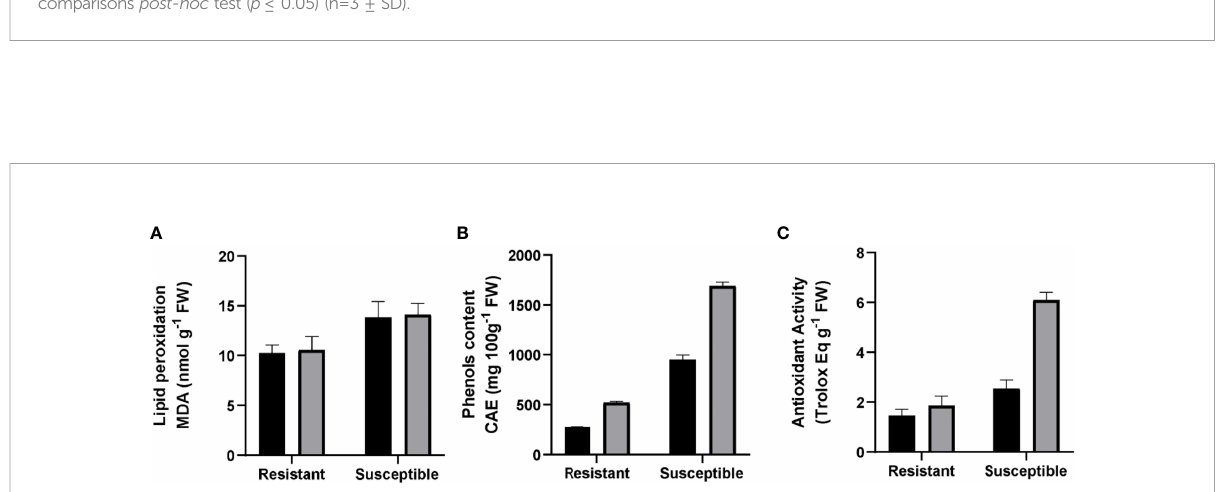
FIGURE 3 Evaluation of antioxidant capacity in resistant and susceptible plants. (A) Malondialdehyde (nmol g -1 FW). (B) Phenols, expressed in chlorogenic acid equivalents (CAE µg g -1 FW). (C) Antioxidant activity, measured by a 2,2-diphenyl-1-picrylhydrazyl radical scavenging assay (DPPH) (Trolox Eq g -1 FW). Black bars represent non inoculated plants, and grey bars indicate E. necator inoculated plants. Lowercase letters indicate statistically signi fi cant differences among inoculated and non-inoculated in factors interaction (genotypes*infection condition). A two-way ANOVA test and the Tukey multiple comparison post-hoc test ( p ≤ 0.05) (n=3 ± SD) were performed.